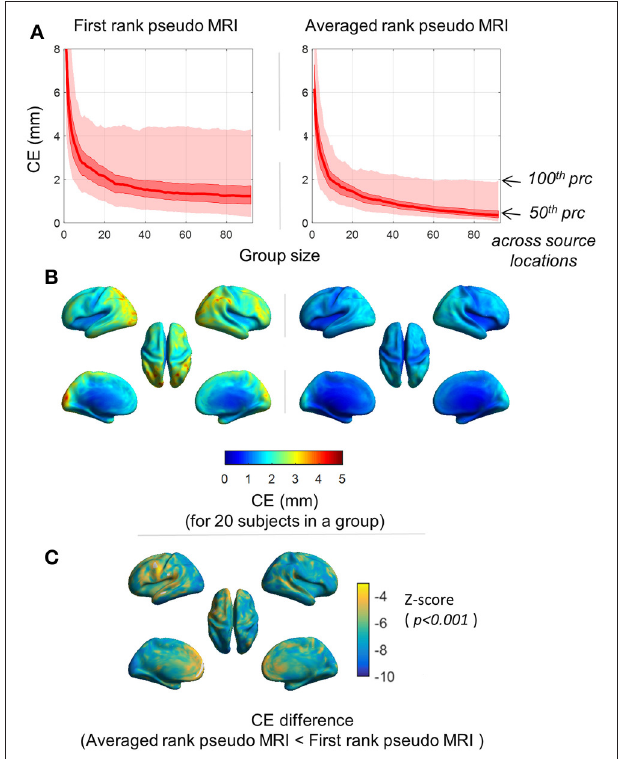
FIGURE 3 | Spatial distribution of the sourcemodel grid point location error (SGPLE). (A) SGPLE for each of sourcemodel grid point locations across the